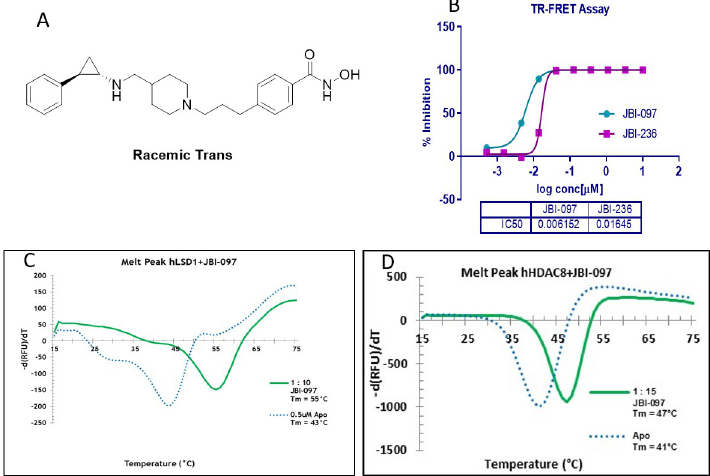
Fig 1. Structure, biochemical activity and melt curve of JBI-097. (1A) Chemical Structure of JBI-097. ( 1B) JBI-097 potently inhibited LSD1 in TR-FRET Assay. The results shown are representative from two independent experiments. ( 1C and 1D) Derivative melt curves of 1C. LSD1 and 1D. HDAC8 in the presence of JBI-097 or DMSO. Experiments were done in triplicates.